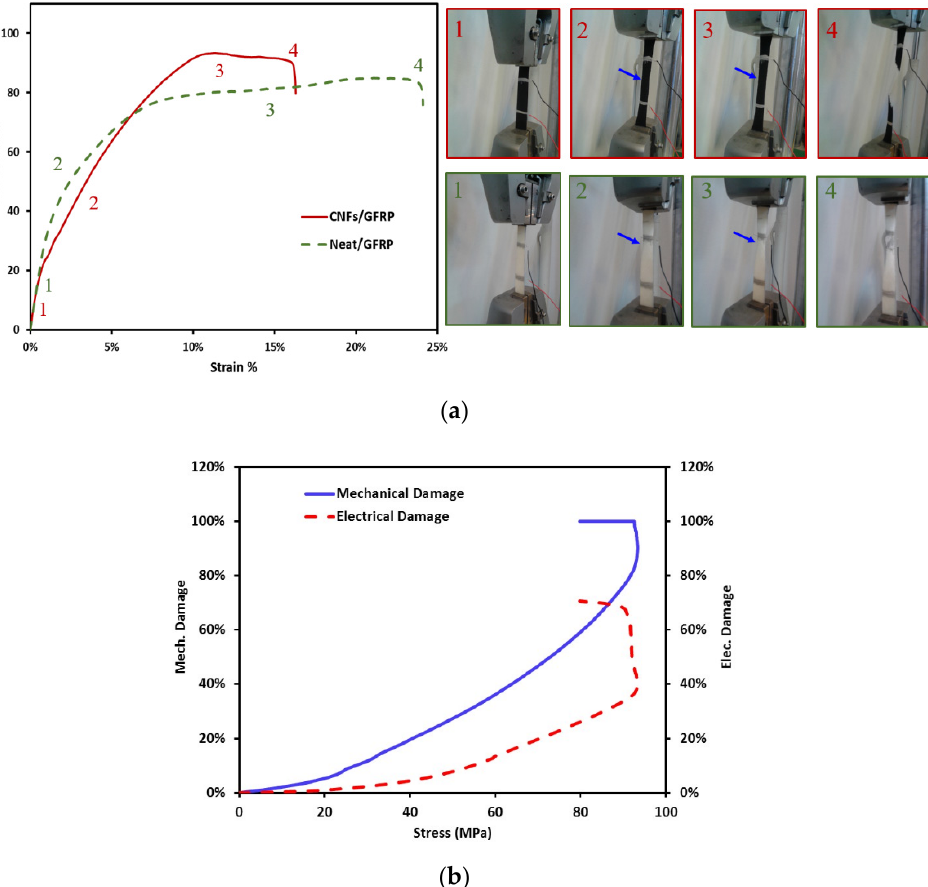
Figure 9. GFRP testing ( a ) Stress–strain curves of GFRP and electrically conductive GFRP incorporating 2.0% CNFs ( b ) stress-electrical damage (DE) and stress-mechanical damage (DM) for glass fiber composite incorporating CNFs under monotonically increasing static tension stress.